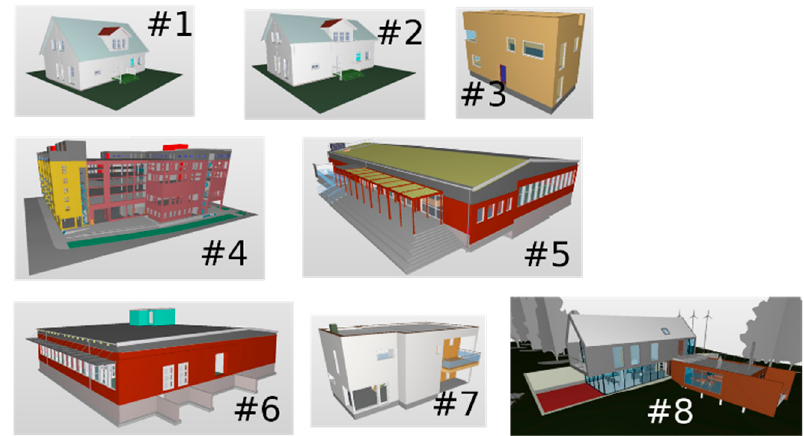
Figure 7. The eight BIM models used for area calculations: #1 Hjältevadshus Spira 168; #2 Hjältevadshus Spira 175; #3 Kamakura House; #4 Multihuset; #5 Nyvångsskolan F; #6 Nyvångsskolan H; #7 KTH demobuilding; and #8 Revit House.